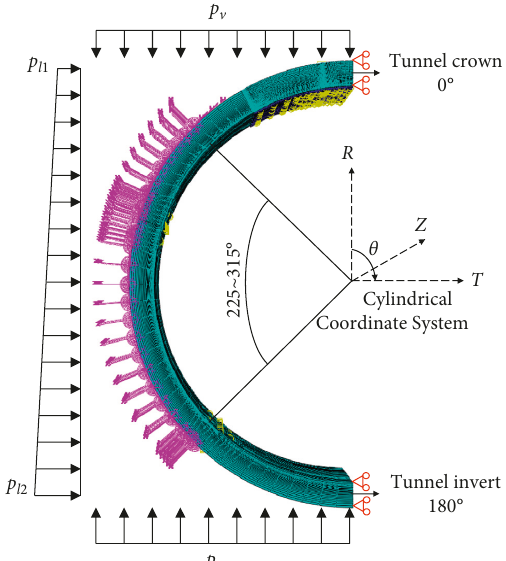
Figure 3: Loads and boundary conditions.